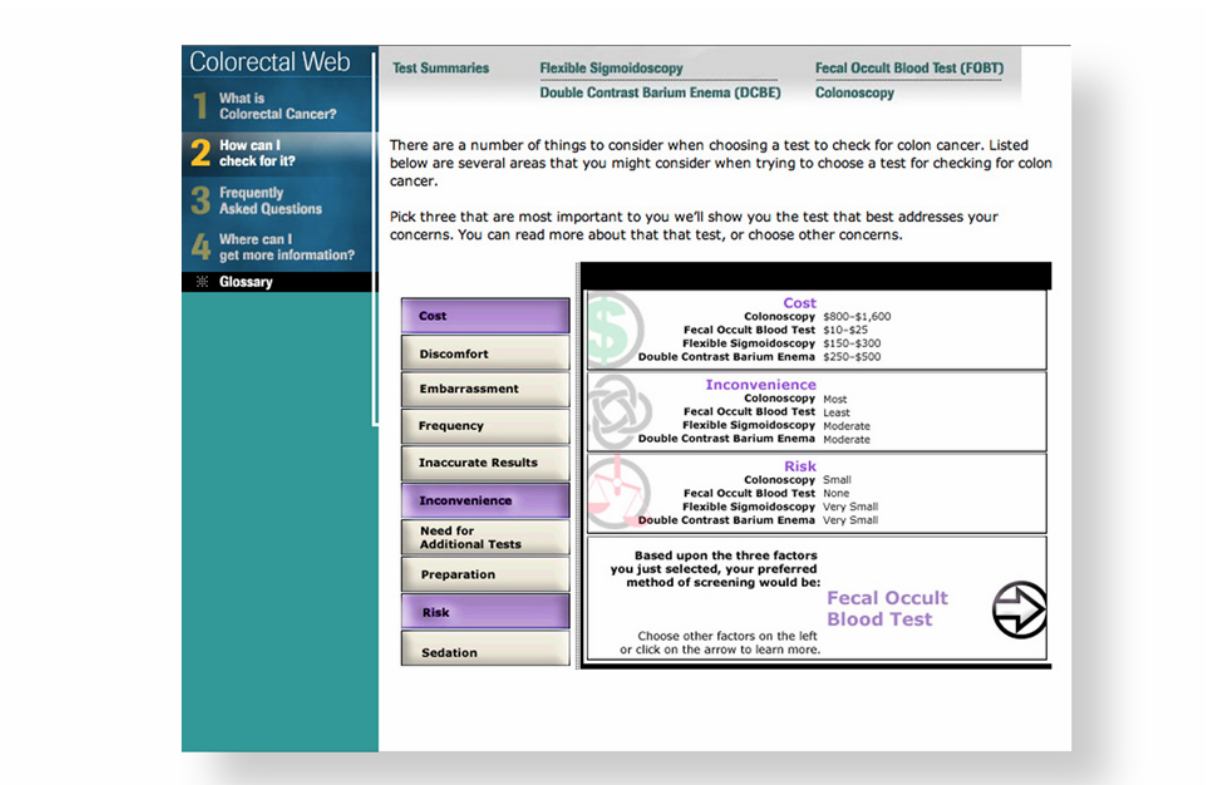
Figure 2. Fecal occult blood test selected as preferred screening